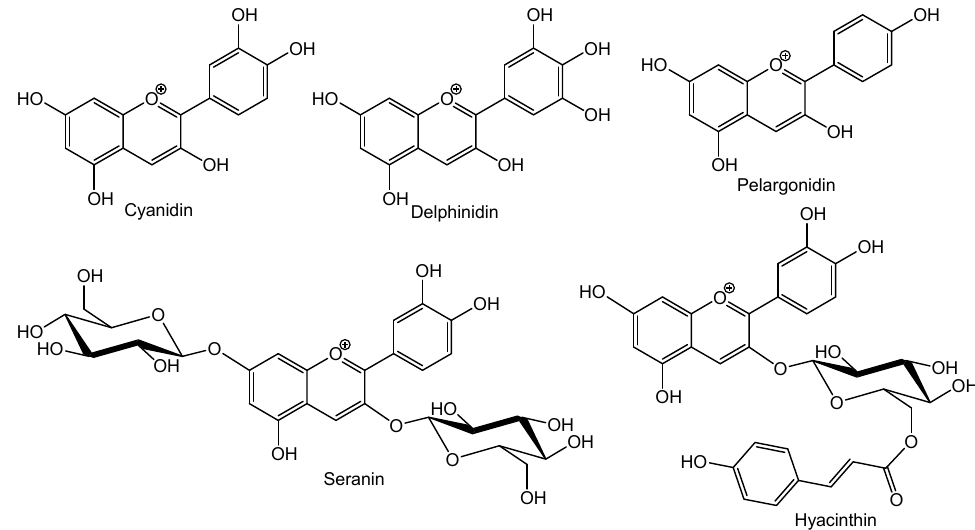
Figure 2. Examples of representative anthocyanidins and anthocyanins.